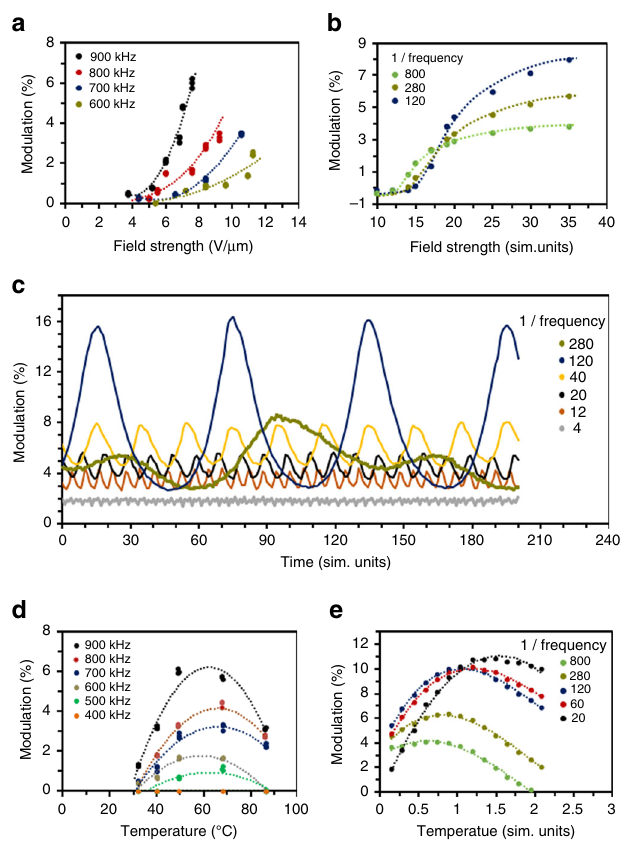
Fig. 3 LCN deformation details. a Measured deformation increases with increasing fi eld strength. The sample is at 46°C. b Simulated volume modulation as a function of fi eld strength at fi xed temperature T = 0.35 sim. units. c Modeled percent volume change through simulation time in the presence of an alternating electric fi eld. Percentage relative to the volume of the sample before the fi eld is applied (see Supplementary Eq. 3). Results are given for different fi eld frequencies (in sim. units), at fi xed temperature ( T = 0.35 sim. units) and fi eld strength ( E = 30 sim. units). d In fl uence of frequency on measured modulation at various temperatures, voltage is kept at 75V. e Volume modulation in simulation as a function of temperature, at fi xed electric fi eld strength of E = 30 sim. units and different fi eld frequencies (in sim. units). Units of measure in simulation are described in the Supplementary Note oscillation continues until the electric fi eld is turned off, at which point the protrusion disappears and the initial state is recovered. Figure 2b is snapshot of a deformation taken at an arbritrary time duringbthe fi eld-on state. Because of the chaotic oscillations, which are random also with respect of their location, the deformation as shown in Fig. 2b may vary in height.